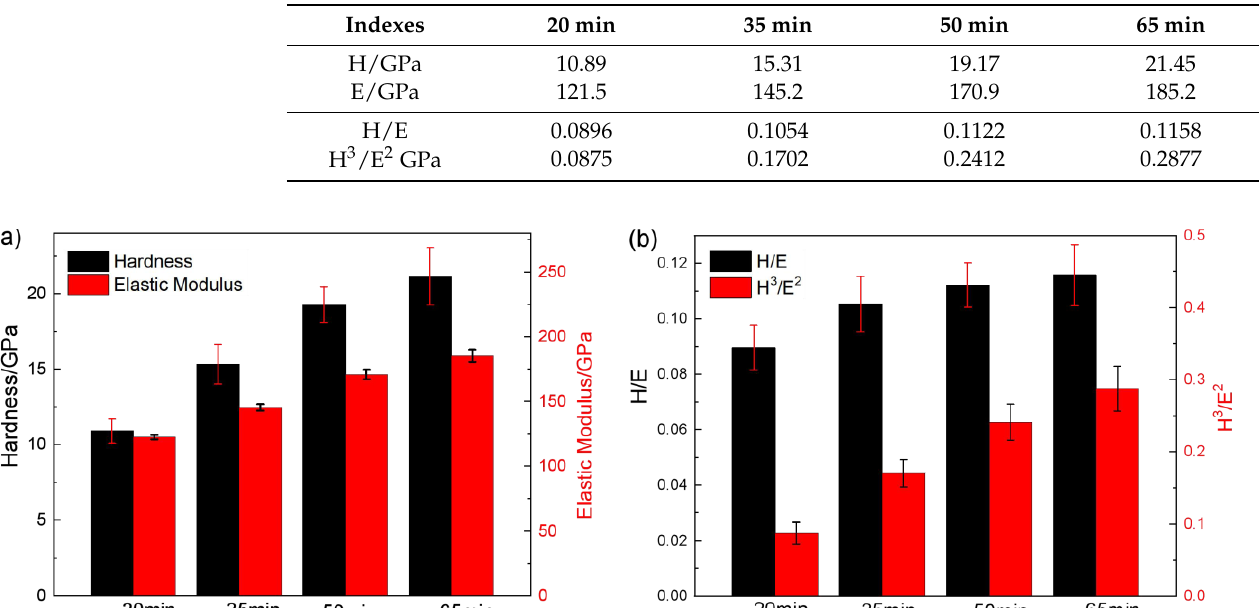
Table 2. Experimental results of nano-indentation test.